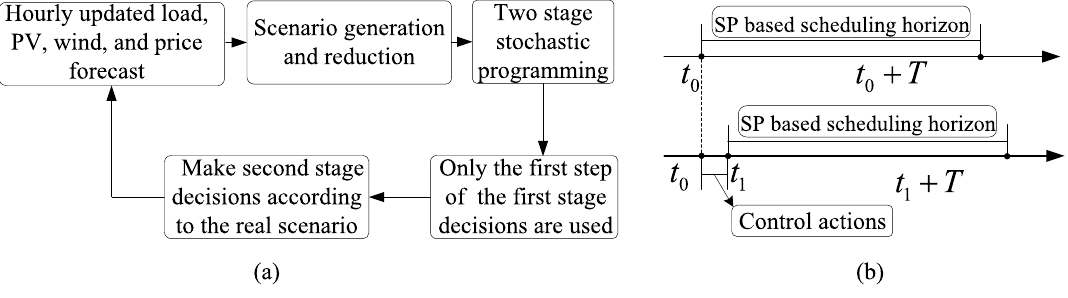
Figure 2. Scheme of combined stochastic programming and receding horizon control (SPRHC) based microgrid (MG) energy management ( a ) flowchart of SPRHC ( b ) receding horizon